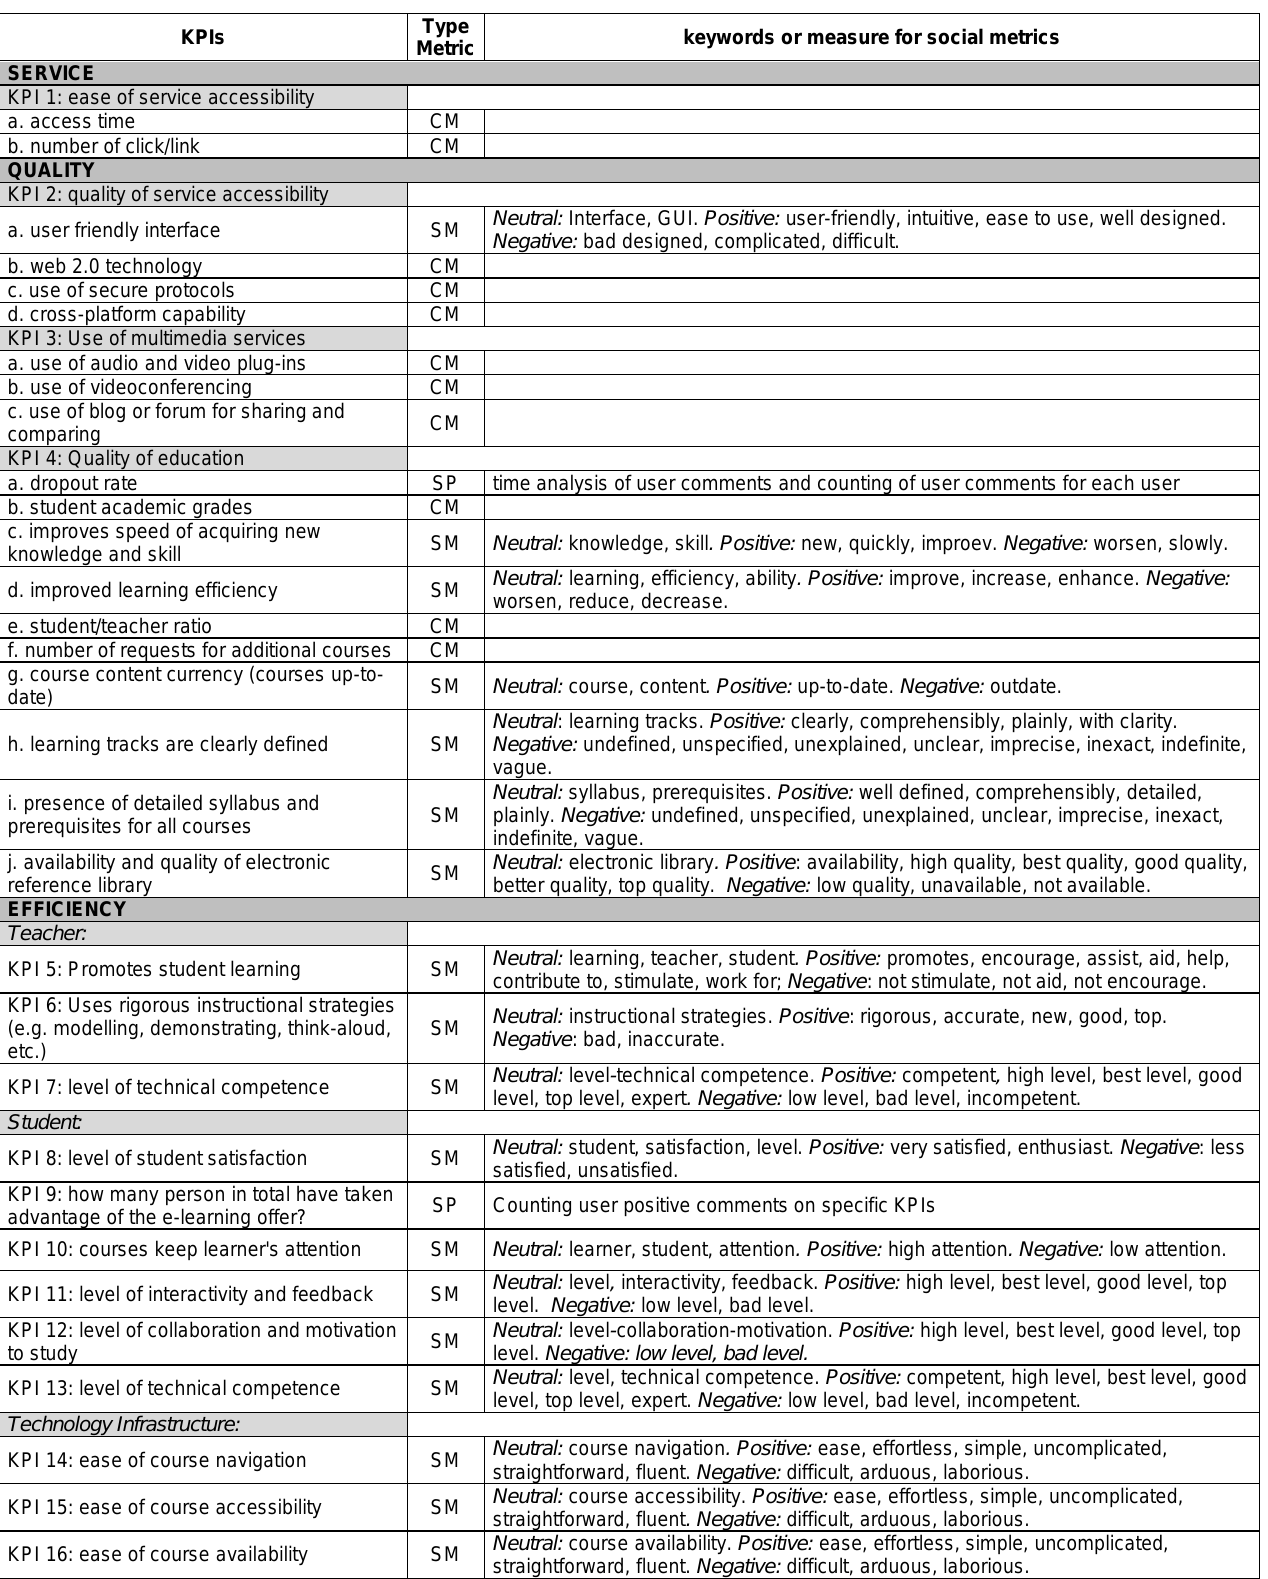
Table 1: KPIs and Social Metrics